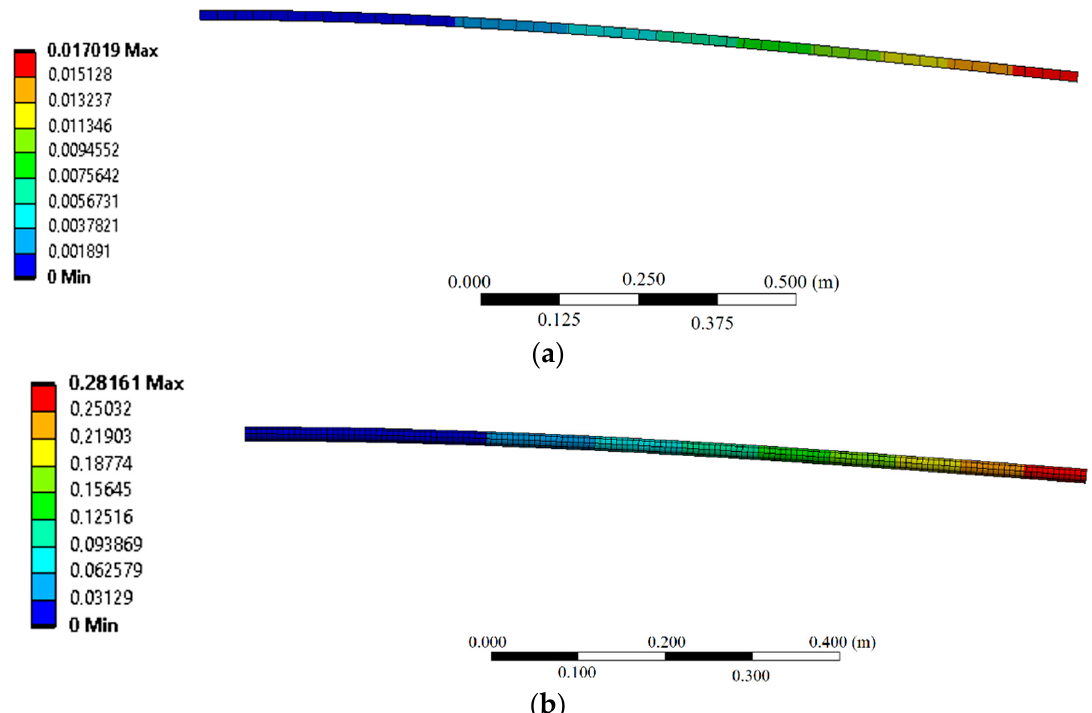
Figure 2. Numerical results of the displacement in the beams with the cantilever configuration for a 5 N load applied on the free end. ( a ) Wooden beam; and ( b ) Nylon 6.0